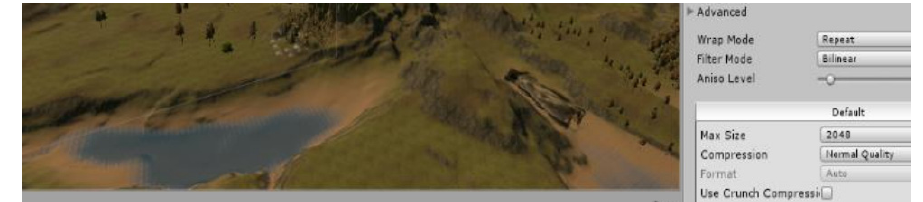
Figure 3. Virtual modeling of the sustaining environment in the Gaia program for implementation into Unity 5.